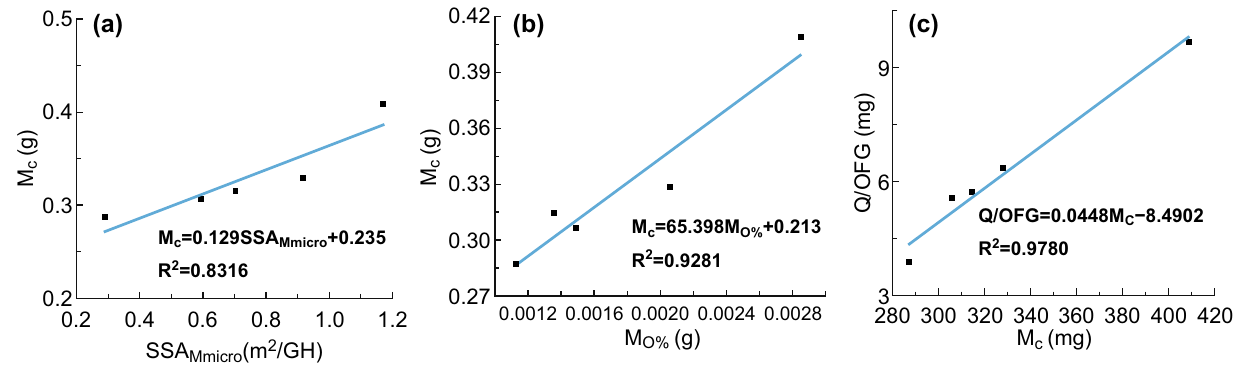
Fig. 7 a The linear fitting results for SSA Mmicro (SSA of the micropores in one GH sample) and M c (mass of confined water in one GH sample); b the linear fitting results for M o% (oxygen content in one GH sample) and M c ; and c the linear fitting results for the M c and Q /OFG (normalized adsorption capacity of the confined water for each GH